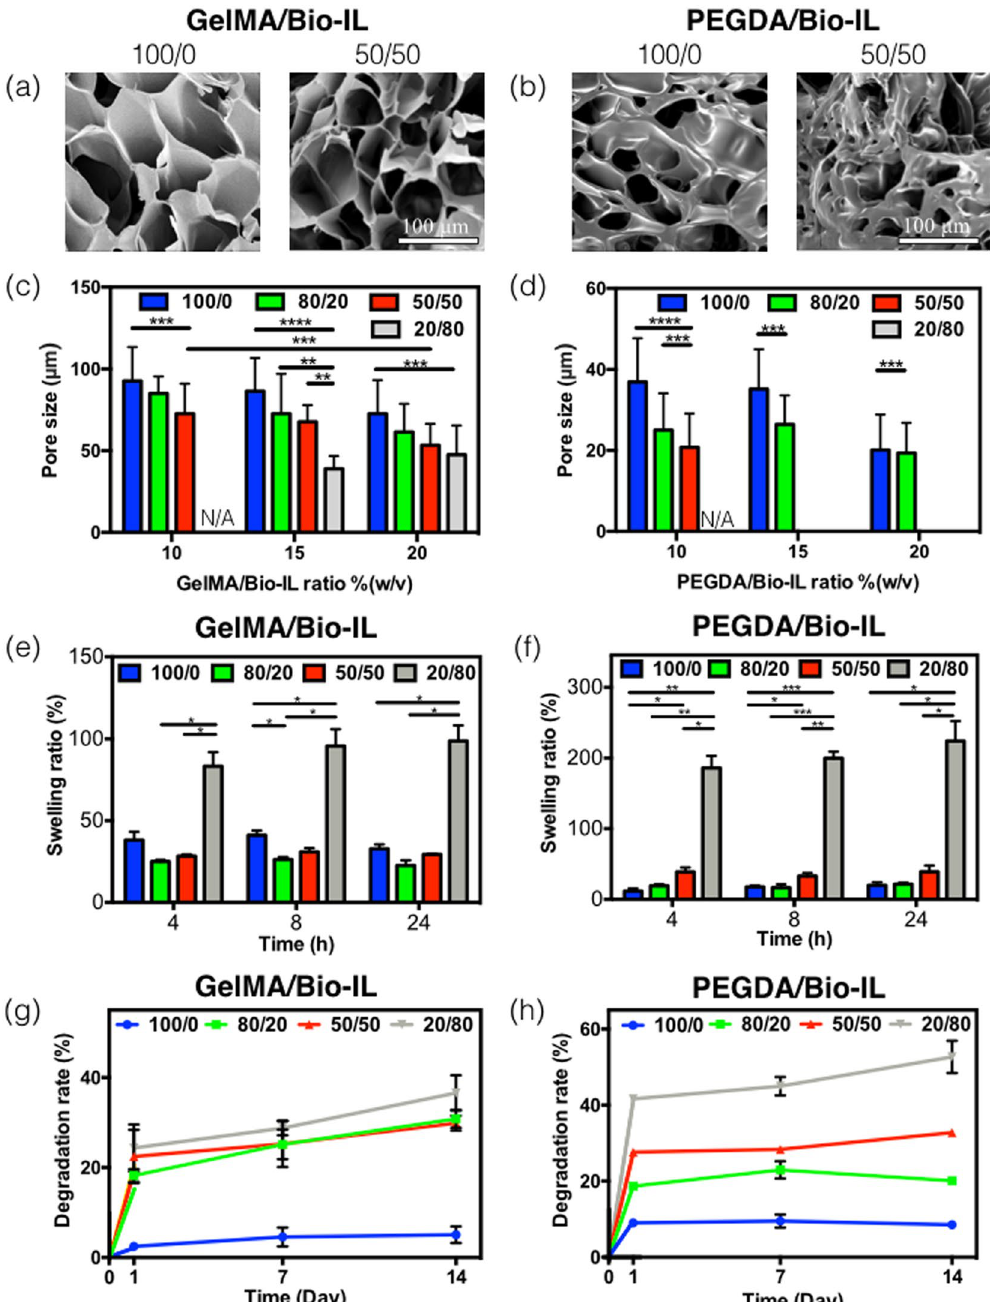
Figure 4. Pore characteristics, in vitro swelling, and degradation of polymer/Bio-IL hydrogels. Representative SEM images of ( a ) GelMA/Bio-IL and ( b ) PEGDA/Bio-IL hydrogels formed by using 100/0 and 50/50 polymer/ Bio-IL ratio at 15% (w/v) polymer concentration (1% VC, 1.5% TEOA, and 0.1 mM Eosin Y at 120 s light exposure were used to form the hydrogels). Average pore sizes of ( c ) GelMA/Bio-IL and ( d ) PEGDA/Bio-IL hydrogels at varying polymer concentrations and polymer/Bio-IL ratios. Swelling ratios of ( e ) GelMA/Bio-IL and ( f ) PEGDA/ Bio-IL hydrogels at 15% final polymer concentration and 50/50 polymer/Bio-IL ratio in DPBS after 4, 8 and 24 h. Degradation of ( g ) GelMA/Bio-IL and ( h ) PEGDA/Bio-IL hydrogels at 15% final polymer concentration and 50/50 polymer/Bio-IL ratio in DPBS supplemented with 10% FBS over a two-week period. Error bars indicate standard error of the means, asterisks mark significance levels of p < 0.05 ( * ), p < 0.01 ( ** ), and p < 0.001 ( ***